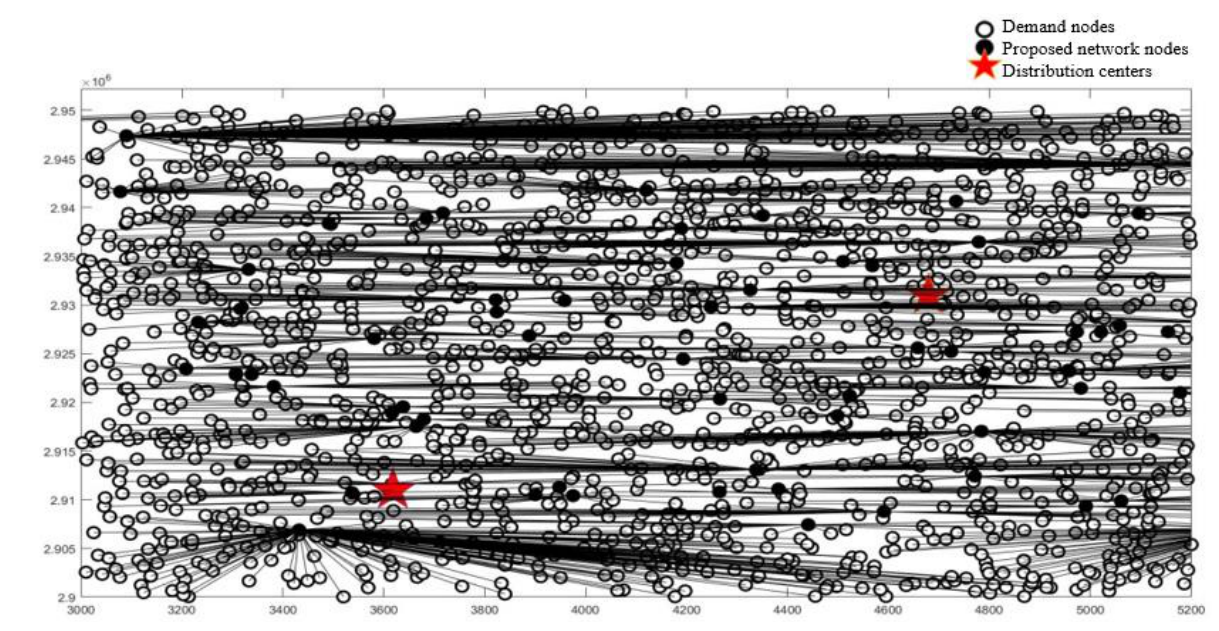
Figure 11. The 101 algorithms recommended location results.